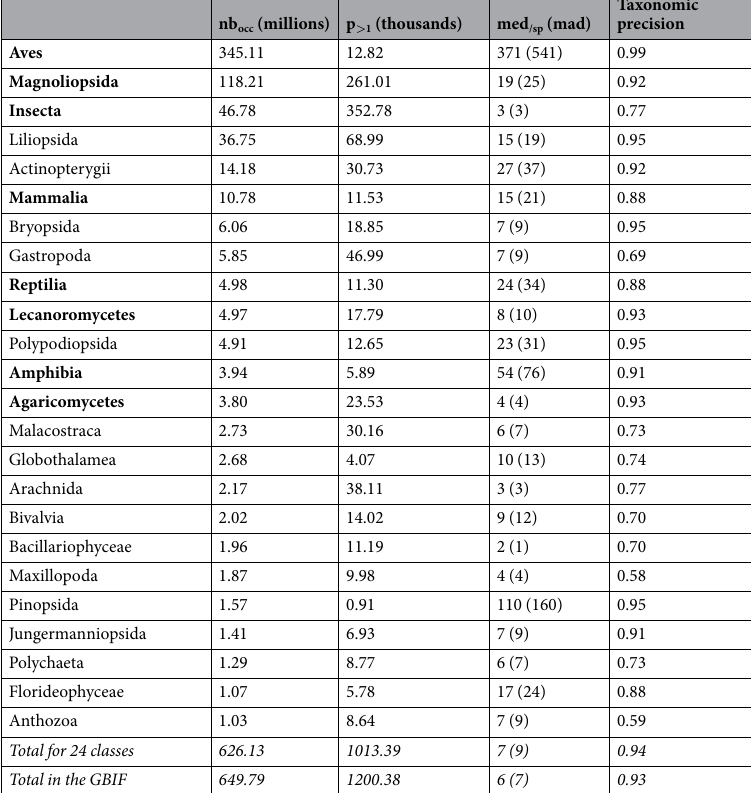
Table 1. Biodiversity occurrence data statistics for 24 taxonomic classes. The number of occurrences (nb occ ) was obtained before the use of any filter. The number of species (p > 1 ) corresponds to the number of unique scientific names having at least one occurrence. In bold are the eight classes selected to study the taxonomic bias at the ordinal level. med /sp is the median number of occurrences per species and mad is the associated median deviation. Taxonomic precision is the proportion of taxa identified at least at the species